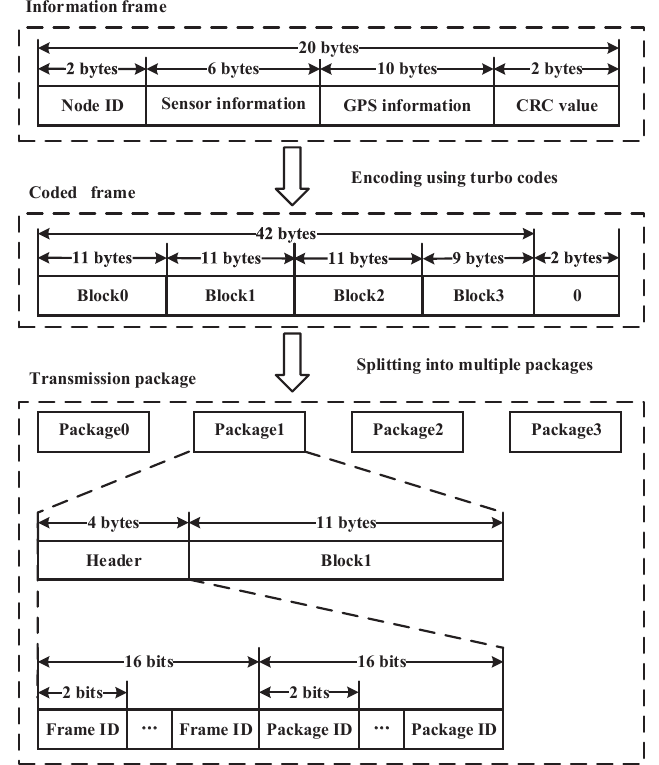
Figure 3. The frame or package formats for macrodiversity